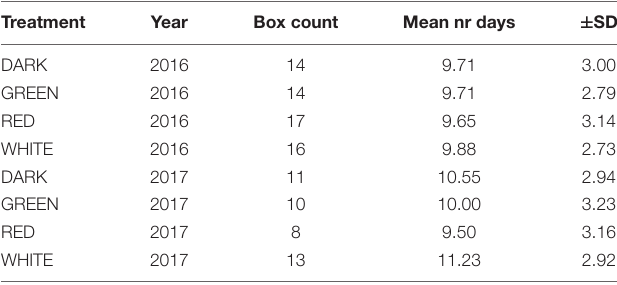
TABLE 1 | Number of nest boxes per light treatment per year included in the